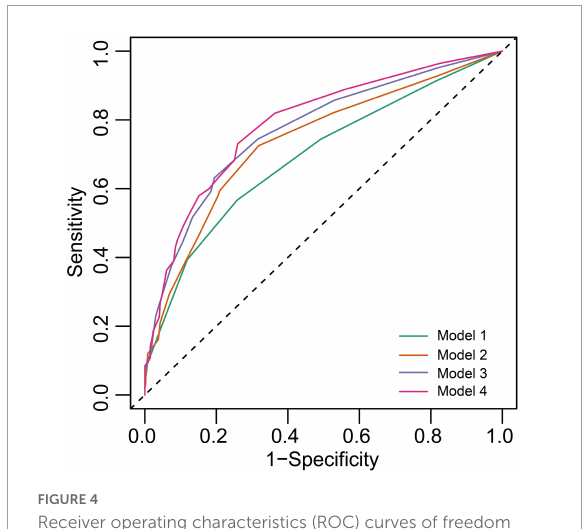
FIGURE4 Receiver operating characteristics (ROC) curves of freedom from ICVE at 5 years for the different risk prediction models. Model 1, CHA 2 DS 2 -VASc score; Model 2, CHA 2 DS 2 -VASc score + abnormal PTFV1; Model 3, CHA 2 DS 2 -VASc score + LAE; Model 4, CHA 2 DS 2 -VASc score + abnormal PTFV1 + LAE.